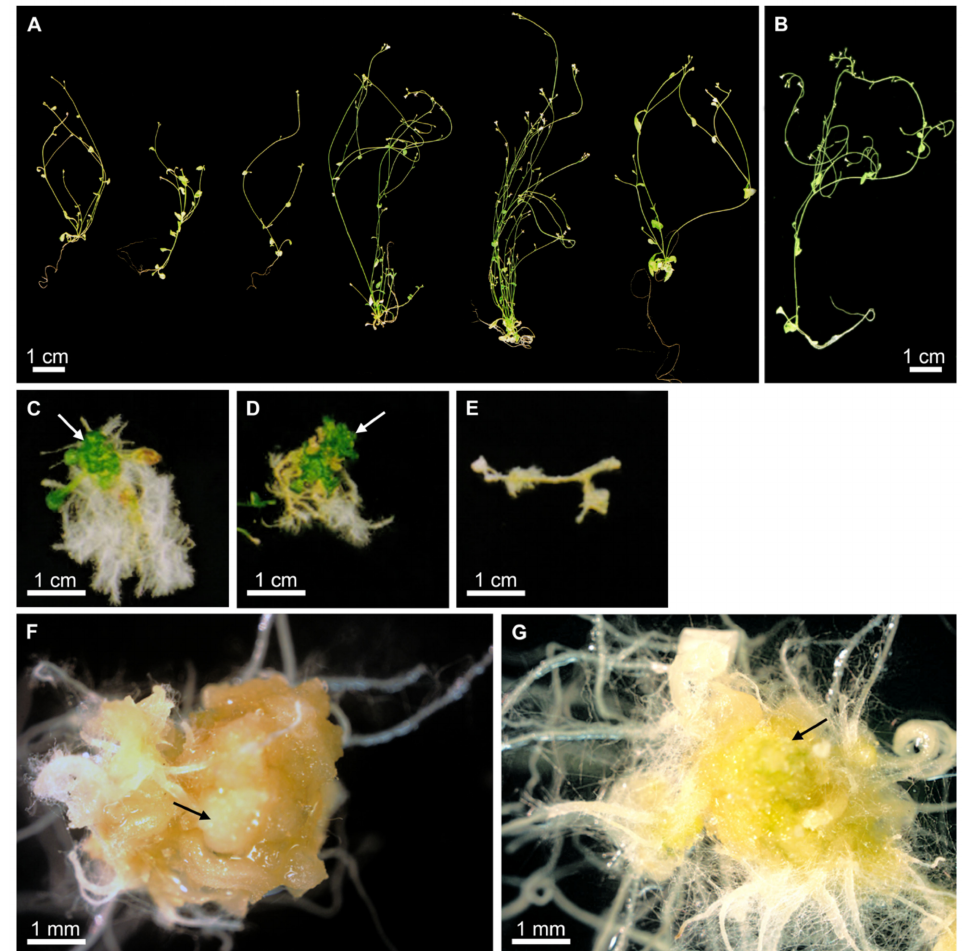
Figure 2. Morphology of Arabidopsis lec1-1 AtLEC1 T1 lines containing the Arabidopsis AtLEC1 transgene. ( A ) Representative T1 lines displaying Arabidopsis seedlings with normal morphology. ( B ) Wild type seedling (control, non-transgenic). ( C , D ) seedlings with multiple cotyledon-like organs (arrows). ( E ) Germinated seedling that stopped further development and died. ( F ) Seedling-derived non- embryogenic callus with smooth surface (arrow). ( G ) Seedling-derived callus with globular stage somatic embryo-like structures